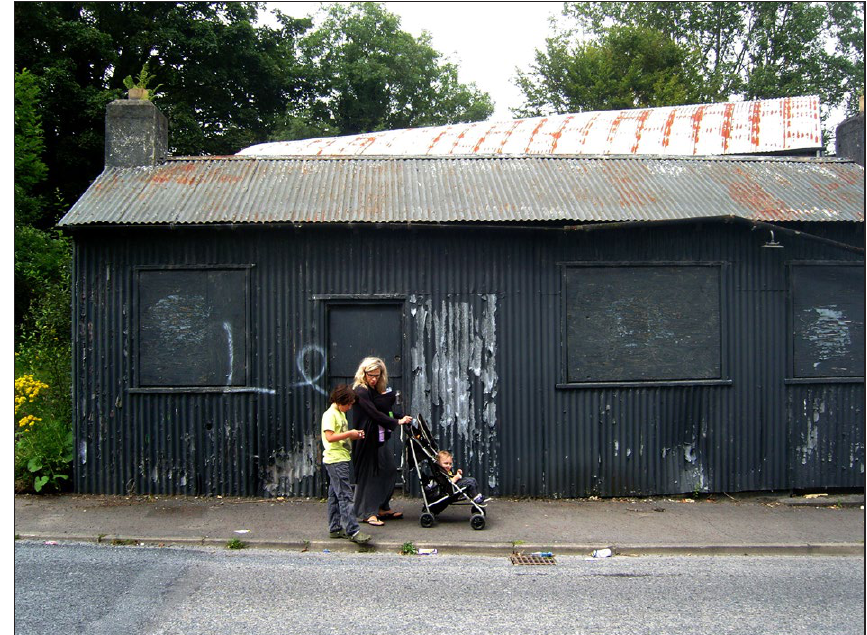
Figure 29: Paula McCloskey, Borderlines , digital photograph,